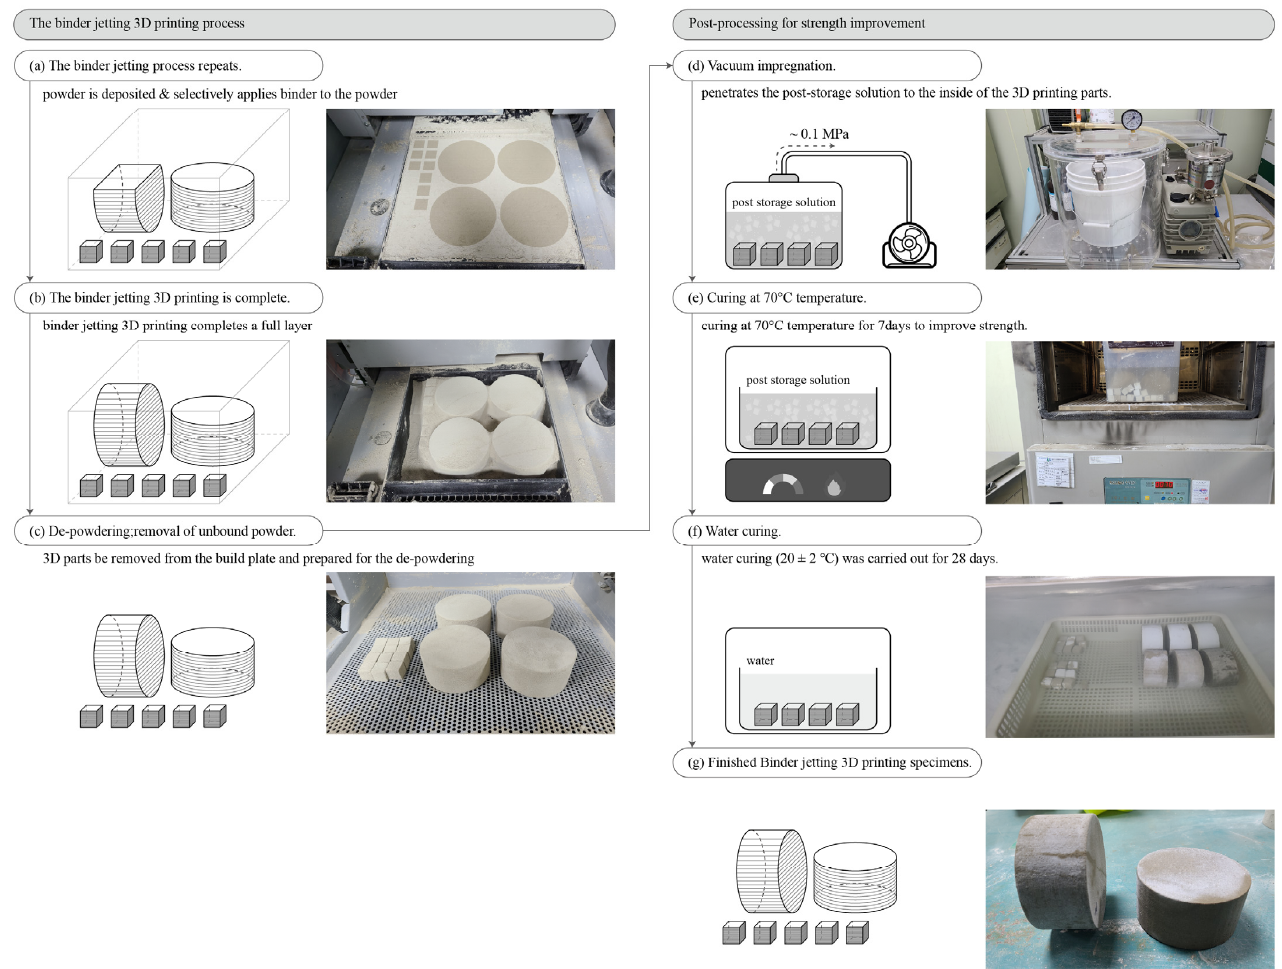
Figure 2. Binder jetting 3D printing process and postprocessing for strength improvement: ( a ) The binder jetting process repeats, ( b ) The binder jetting 3D printing is complete, ( c ) De-powdering removal of unbound powder, ( d ) Vacuum impregnation, ( e ) Curing at 70 ℃ temperature, ( f ) Water curing, and ( g ) Finished Binder jetting 3D printing specimen